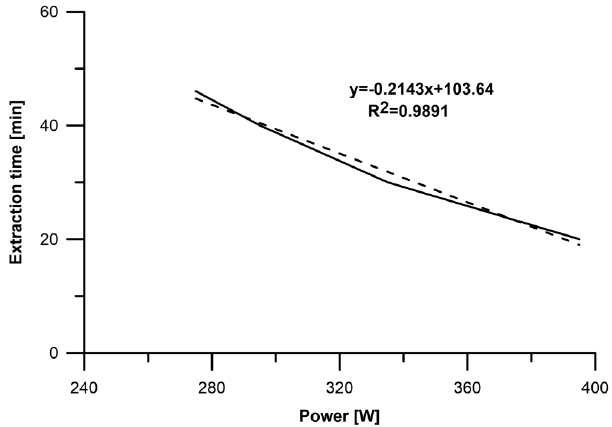
Figure 4. The function of the extraction time from the microwave power for the microwave-assisted hydrodistillation.